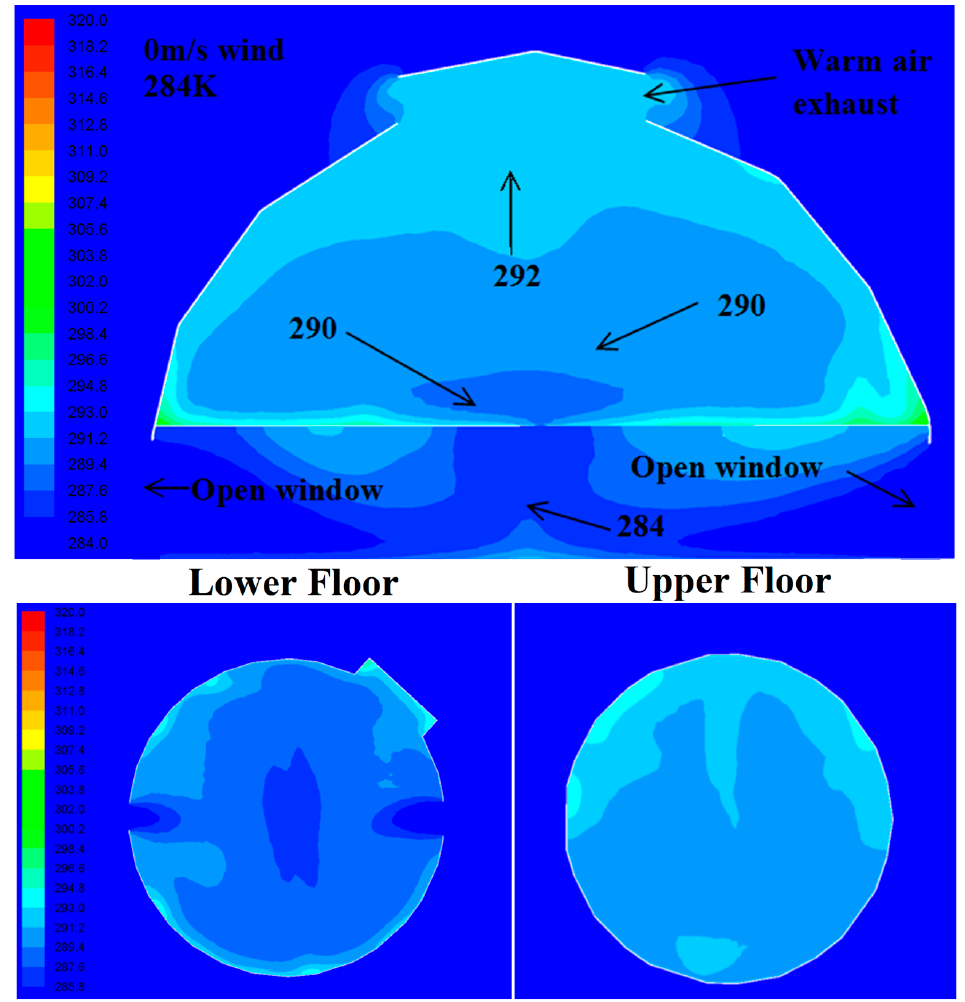
Figure 18. Mid-plane contour plot of the temperature distribution inside the dome with during summer and winter (buoyancy-induced flows).